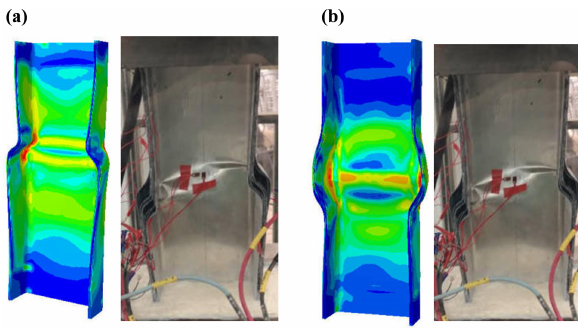
Figure 10: Final failure modes of compression columns: (a) DCYG-A and (b) DCYG-B.